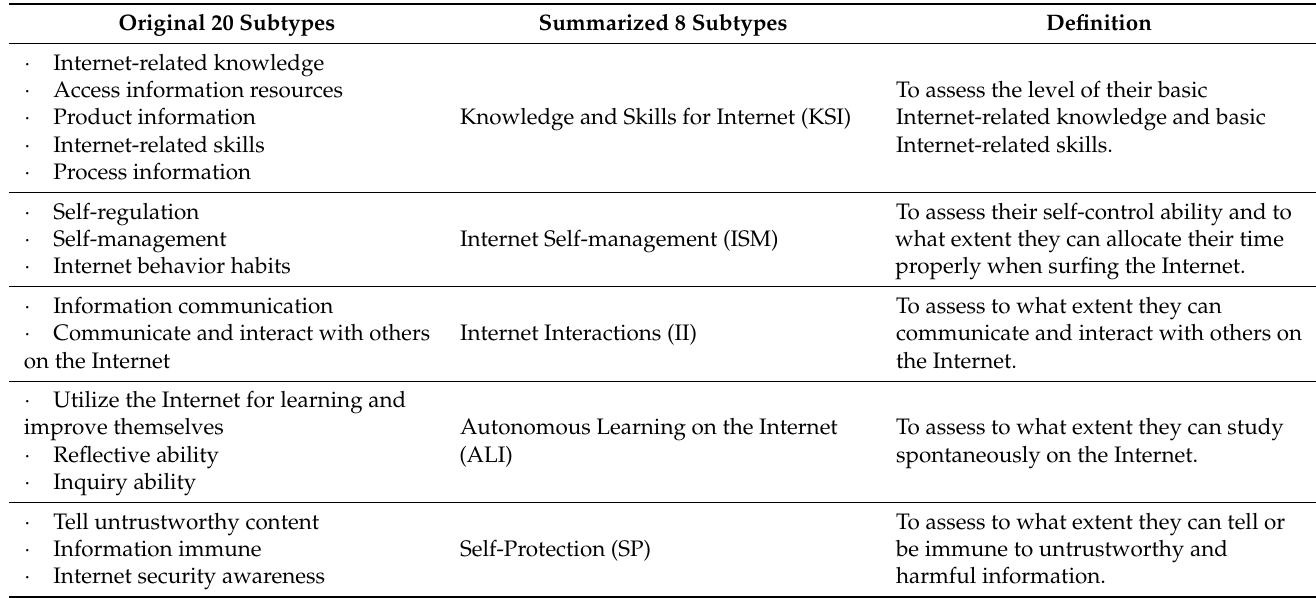
Table 2. The corresponding relationships between original subtypes and new subtypes of Internet